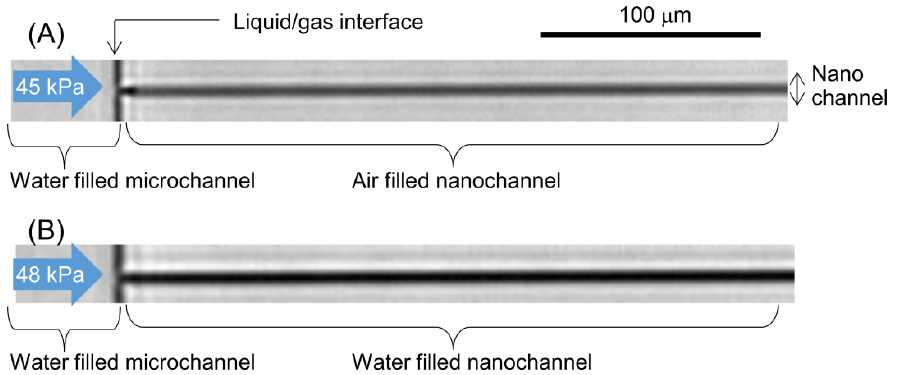
Figure 5. Images of water introduction into hydrophobic nanochannel: ( A ) before water was intro- duced under an applied pressure of 45 kPa; ( B ) after water was introduced under an applied pressure of 48 kPa.